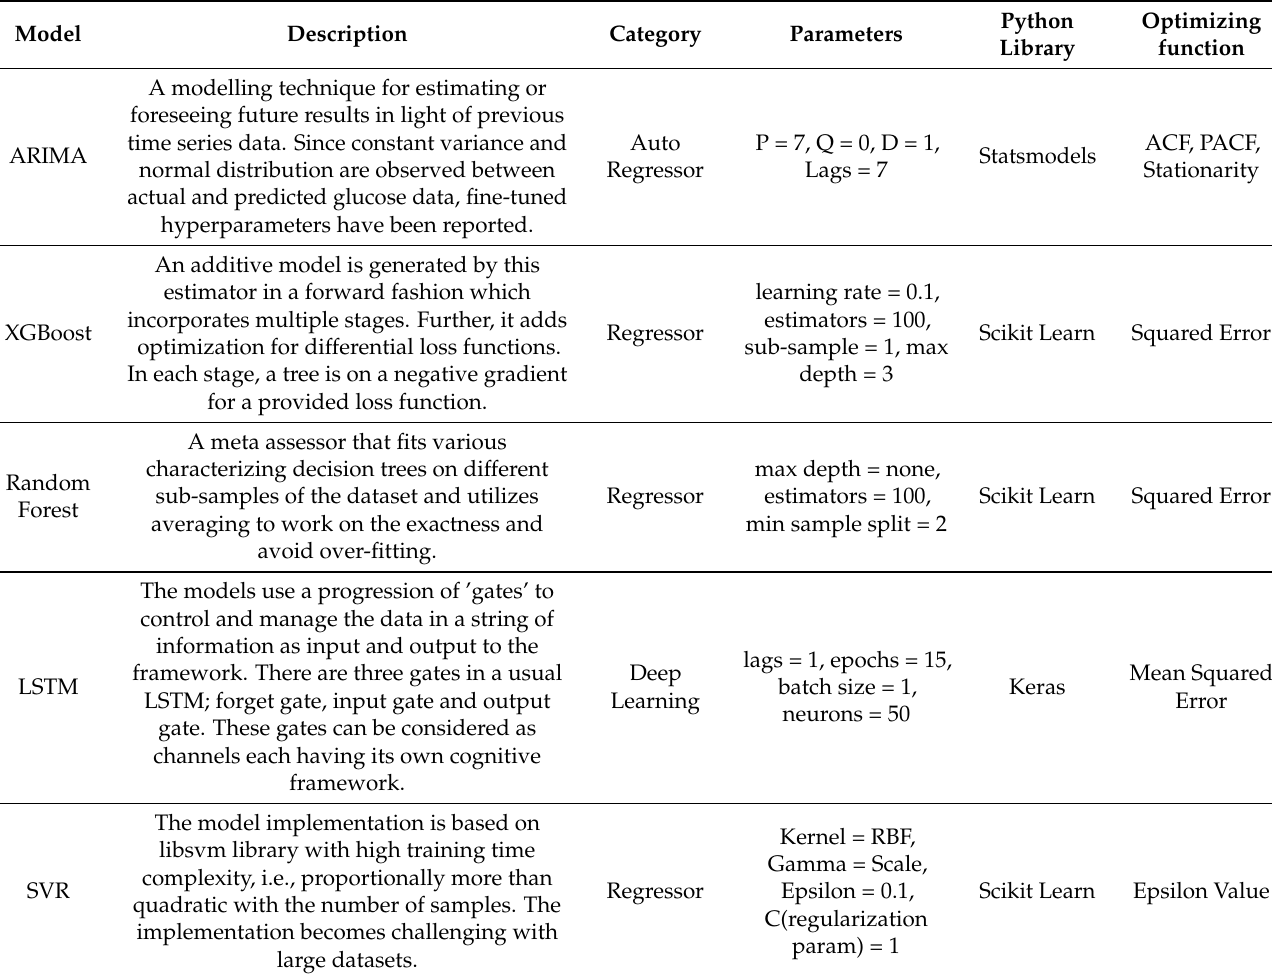
Table 3. Machine learning and deep learning model training parameters and their